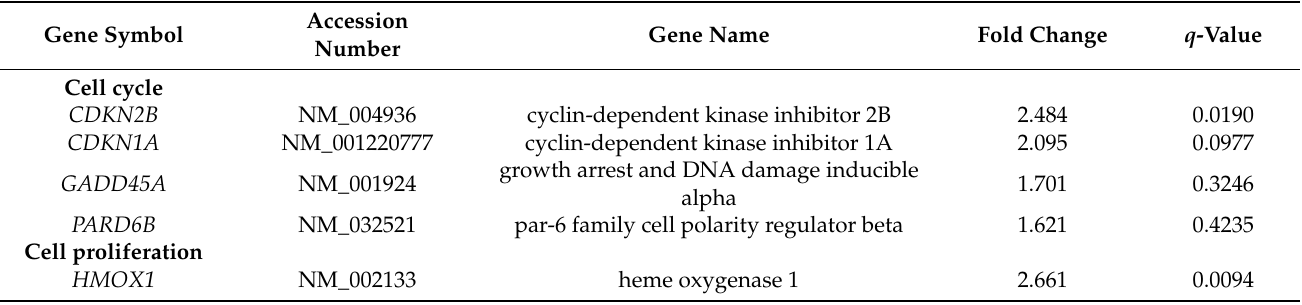
Figure 2. DAA treatment in AGS cells regulated the expression of various genes. ( A ) RNA sequencing was performed on samples prepped from AGS cells that underwent DAA treatment for 48 h. Then, the results of analyzing gene annotation were calculated (upregulated genes: fold change > 1.5, downregulated genes: fold change < 1.5, DAA/DMSO). ( B ) The heatmap shows 33 upregulated genes and 33 downregulated genes showing significant differences in expression. ( C ) Results of RT-PCR on genes (24 of the 33 upregulated genes, 22 of the 33 downregulated genes) analyzed via a heatmap. Table 1. Genes that are upregulated by DAA treatment in AGS cells.